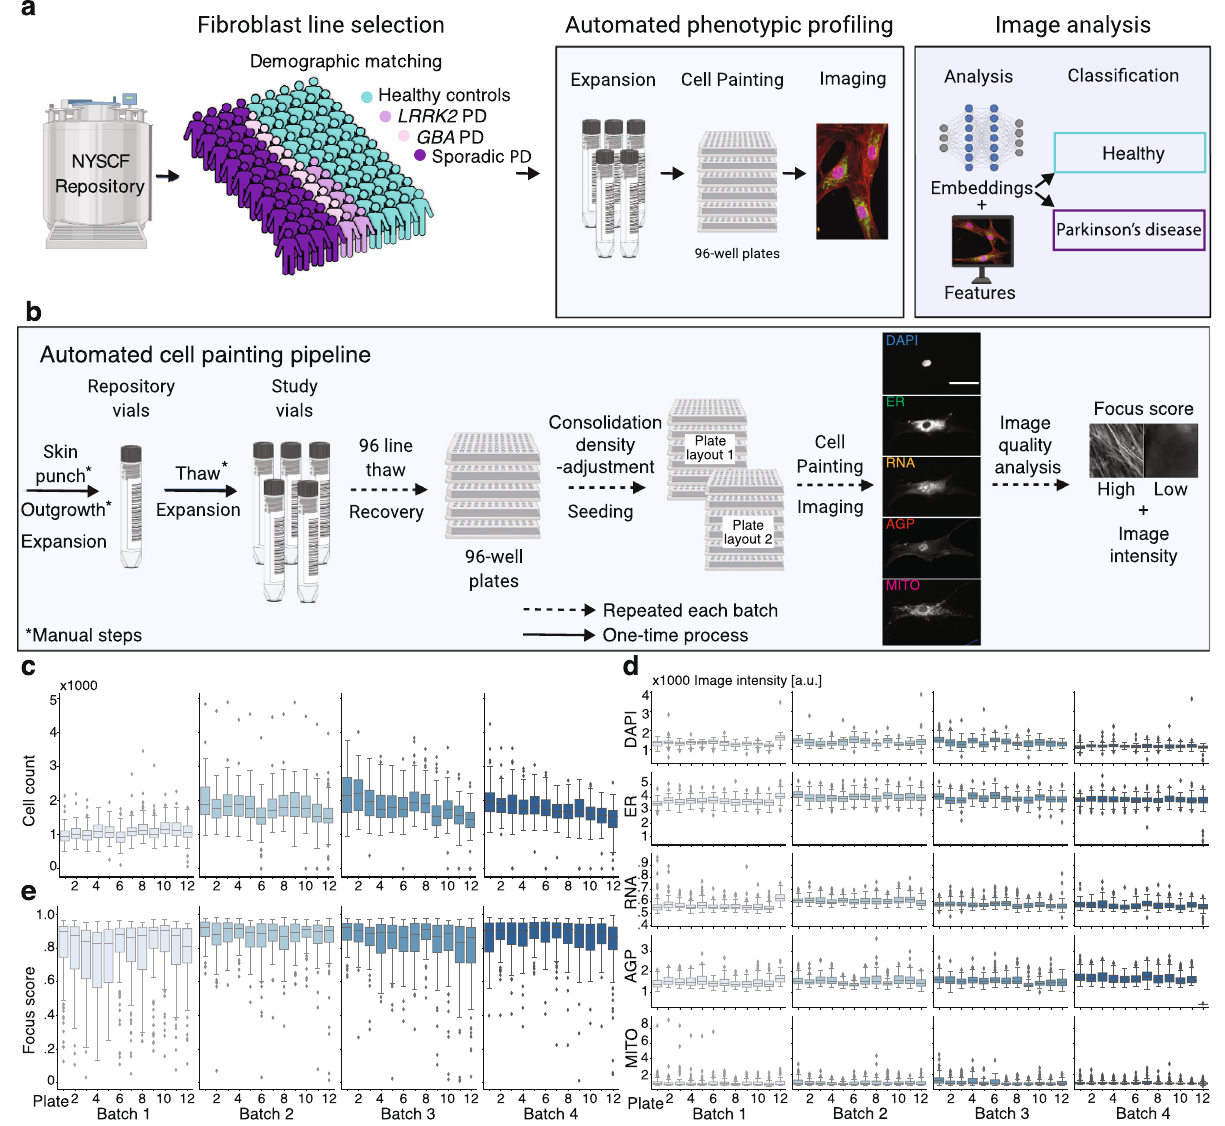
Fig. 1 Automated high-content pro fi ling platform demonstrates reproducibility across batches. a Work fl ow overview. b Overview of automated experimental pipeline. Scale bar: 35 μ m. Running this pipeline yielded low variation across batches in: c well-level cell count; d well-level foreground staining intensity distribution per channel and plate; and e well-level image focus across the endoplasmic reticulum (ER) channel per plate, for n = 96 wells per plate. Box plot components are: horizontal line, median; box, interquartile range; whiskers, 1.5× interquartile range; black squares,